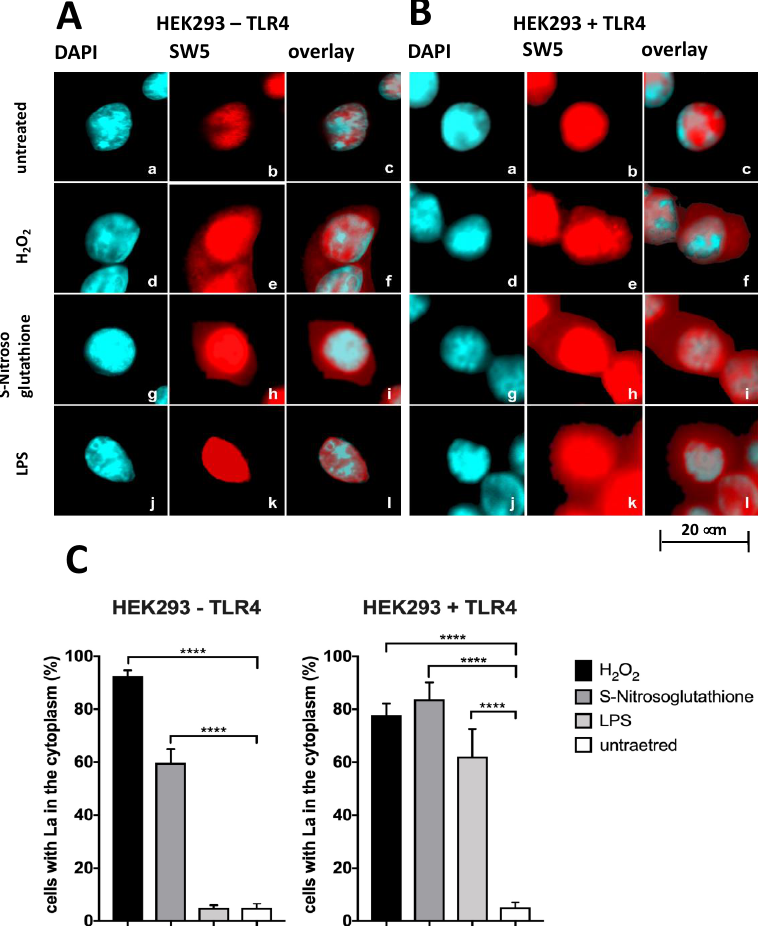
Figure 6. Shuttling of La protein in dependence on Toll-like Receptor/Ligand ligation . ( A,B ) HEK293T cells lacking (HEK293T-TLR4) or overexpressing (HEK293T+TLR4) TLR4 were stained with DAPI ( a , d , g , j ) or the anti-La mAb SW5 ( b , e , h , k ). Overlay of both is shown ( c , f , i , l ). ( a – c ) Untreated cells. ( d – f ) Cells treated with H 2 O 2 . ( g – i ) Cells treated with S-Nitrosoglutathione. ( j – l ) Cells treated with LPS. ( C ) Quantitative evaluation. p Value < 0.0001 = ****.